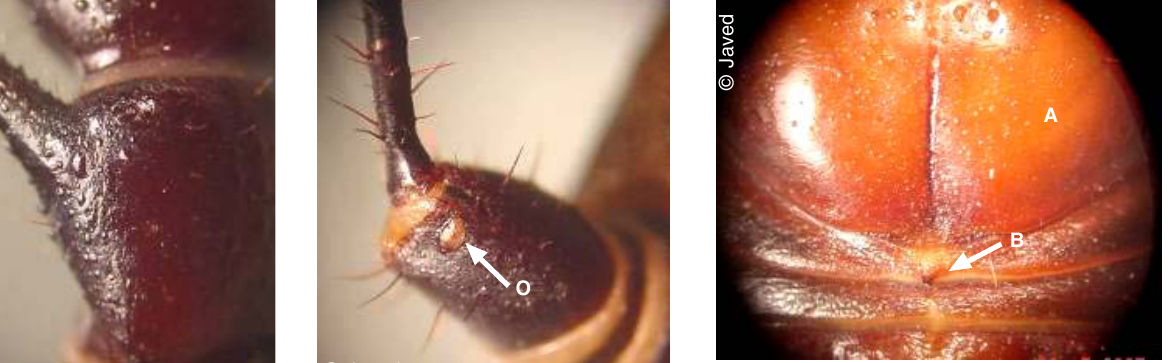
© Javed Image 6. Dorsal view of patella of right pedipalp showing patellar apophysis